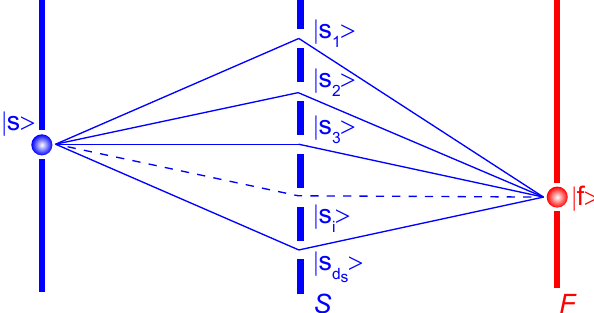
Figure 1: Illustrating the procedure behind the Aharonov– Bergmann–Lebowitz rule using a multiple-slit setup. With non- destructive measurements, one may envisage a situation where the system S is prepared (pre-selected) in state | s (cid:105) (assumed for simplicity to be a pure state; the argument can equally well be carried through if the pre-selected state is a mixture), then subjected to a first measurement of the observable S , followed by a second measurement, now of another observable F. Of all the possible results of the this second measurement, only those which give rise to one particular post-selected eigenstate | f (cid:105) of F are kept in the Aharonov–Bergmann–Lebowitz rule.